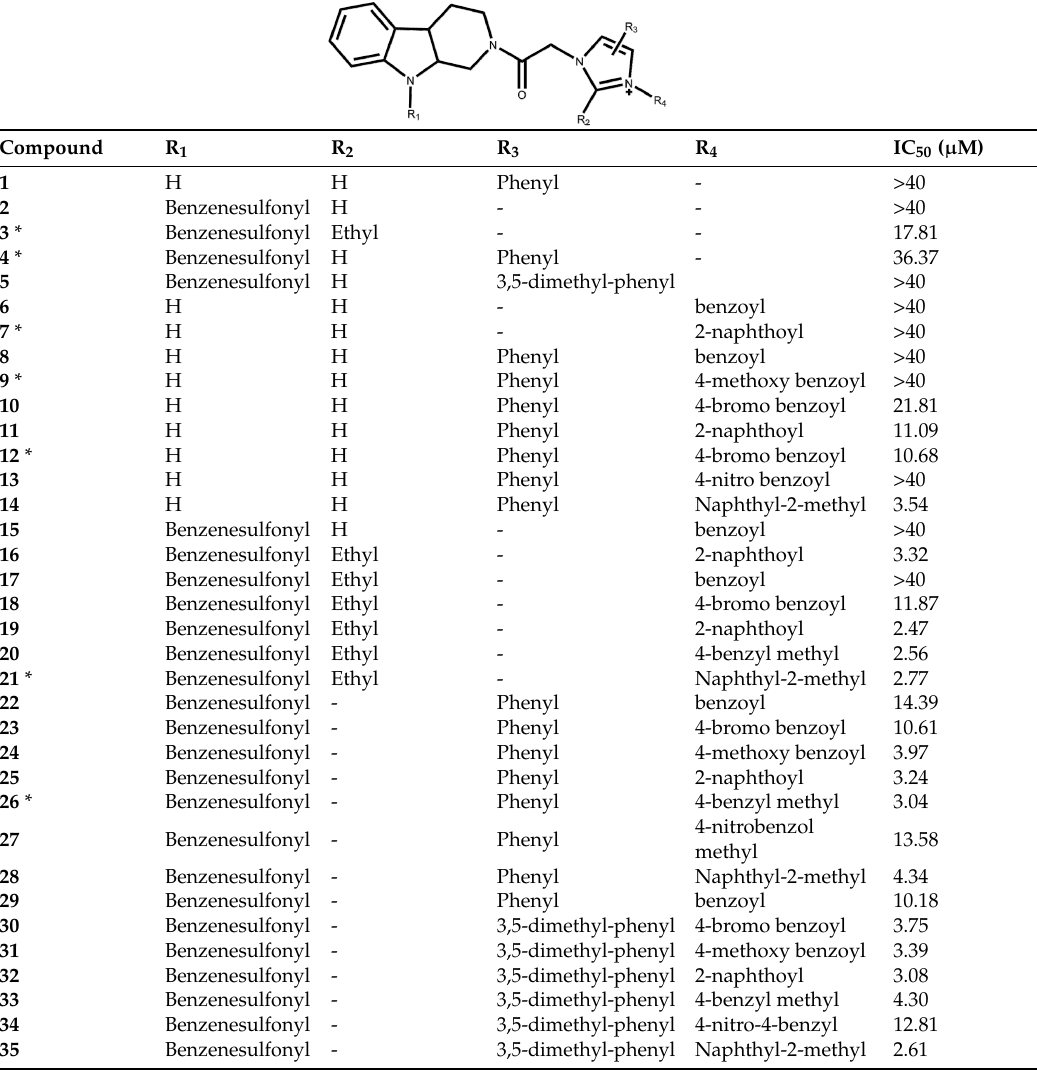
Table 2. Structure of N -substituted tetrahydro- β -carboline imidazolium salt derivatives with the actual activity.